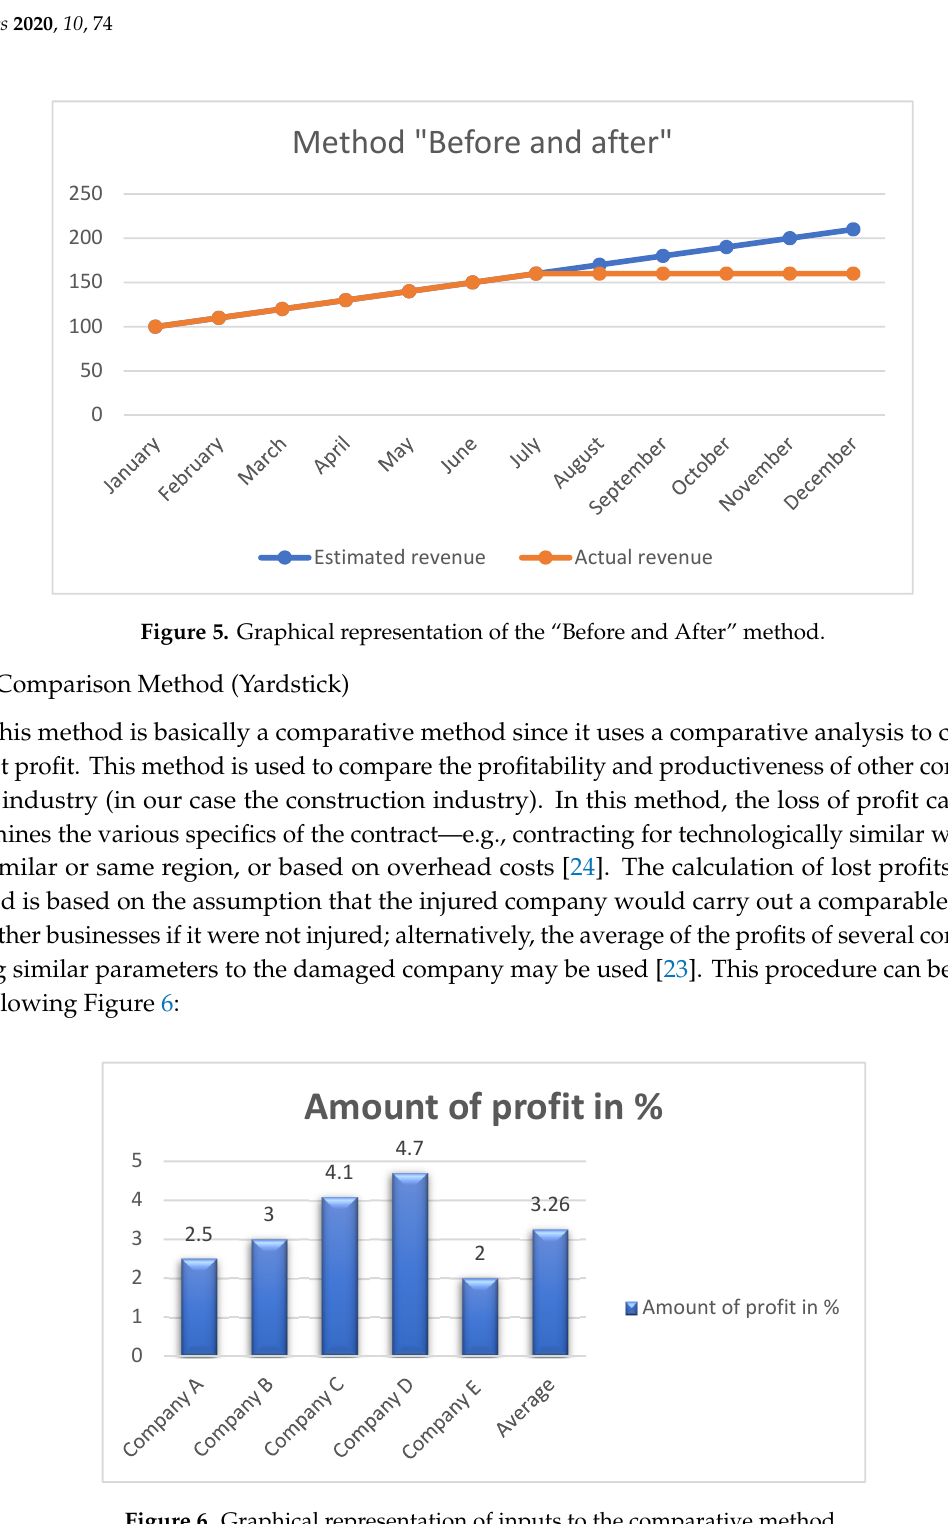
Figure 6. Graphical representation of inputs to the comparative method.